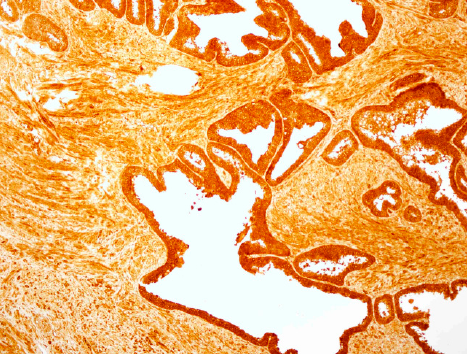
Figure A2 . ( a ) Immunohistochemical staining of hPSA with standard monoclonal antibody ER-PR8 (1:100), compared to staining using antisense peptide Biotin-AVRDKVG in dilutions: ( b ) 1:50, ( c ) 1:100 and ( d ) 1:200.